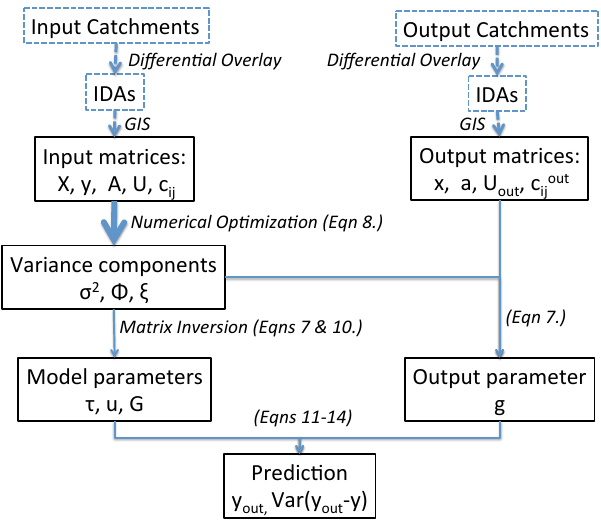
Figure 9. Algorithmic chart of the provided TopREML implemen- tation. Dashed frames and arrows represent vector data and opera- tions and the bold arrow represents the step requiring numerical op- timization. The complexity of the computational tasks represented by the remaining plain arrows is driven by matrix inversion, which is of polynomial complexity. In the figure, X is a matrix of observed covariates and y a vector of outcomes measured at the available gauges, as defined in Eq. (1); x is a vector of identical covariates observed at the prediction location. A , U and c ij are matrices of relative catchment areas, network topology and inter-centroidal dis- tances of the available gauges, as defined in Eq. (6); a , U out and c out are equivalent matrices for the prediction location. σ 2 , φ and ξ ij are estimated variance parameters as defined in Eq. (3); τ , u and G are the estimated fixed and random effects (Eq. 11) and variance– covariance matrix (Eq. 7); g is the estimated covariance at the pre- diction location (used in Eq. 13). Finally, y out and Var (y out − y) are the predicted outcome and the related prediction variance.